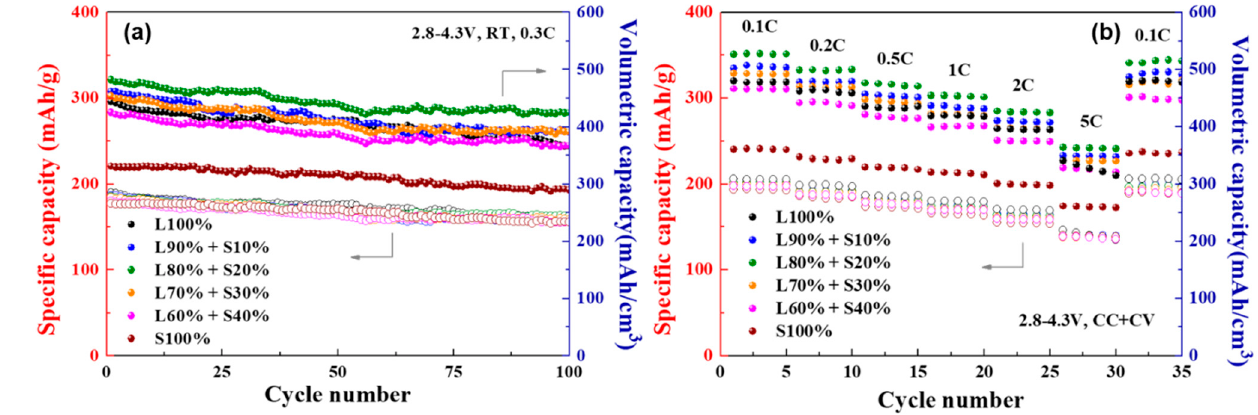
Figure 7. ( a ) Cyclic stability plot of cells made with single and bimodal cathodes at 0.3 C rate (temperature, RT; voltage window, 2.8–4.3 V) and ( b ) rate performance in terms of specific and volumetric discharge capacity.